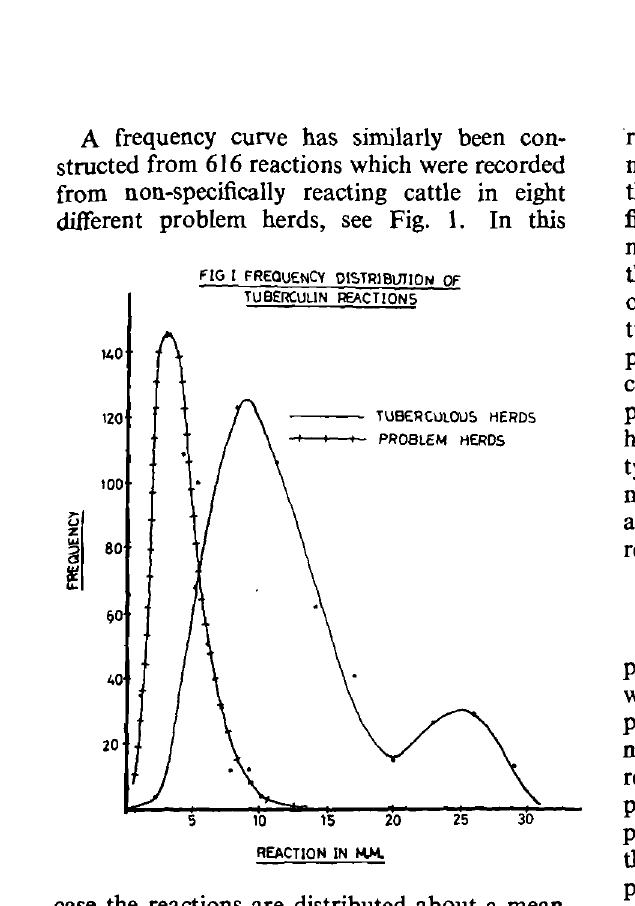
FIG I FREQUENcY OI~TRIBtJTJON OF TUBERCULIN REACTIONS